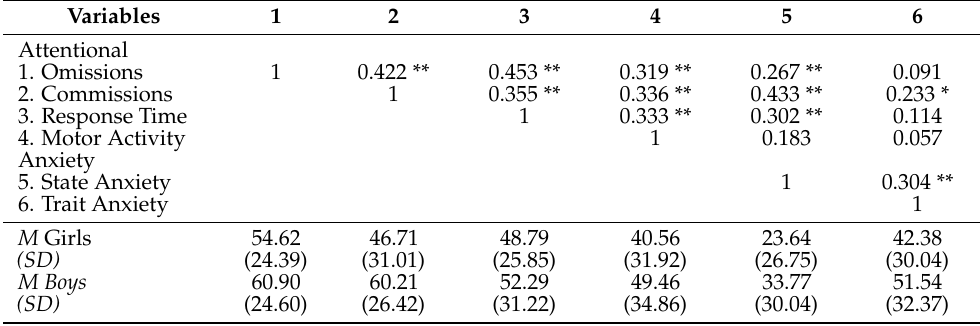
Table 1. Bivariate Pearson correlations between attentional and anxiety variables.